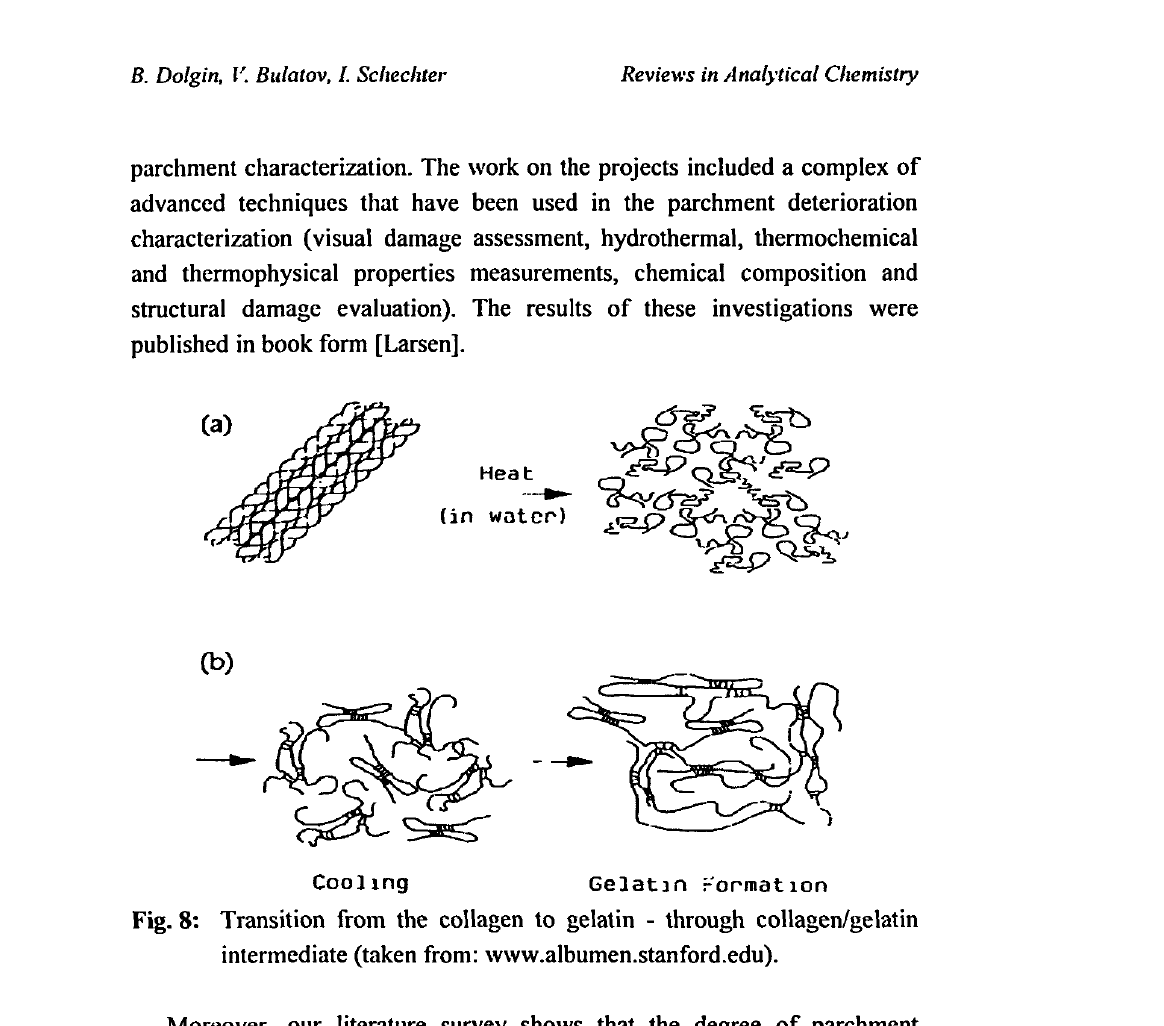
Fig. 8: Transition from the collagen to gelatin - through collagen/gelatin intermediate (taken from: